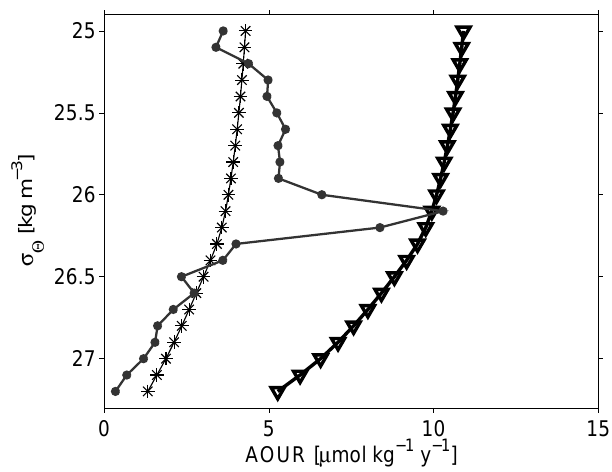
Figure 17. Three estimates of AOUR as a function of density: Schneider et al. (2012) used the TTD approach for the ETNA (stars), Karstensen et al. (2008) used CFC-11 water ages from the ventilated gyre only (triangles), and based on the ratio of North Atlantic mean AOU for isopycnal volumes and the corresponding reservoir ages (black dots, see further details, e.g. reservoir ages and volumes, in Karstensen et al., 2008; Figs. 9 and